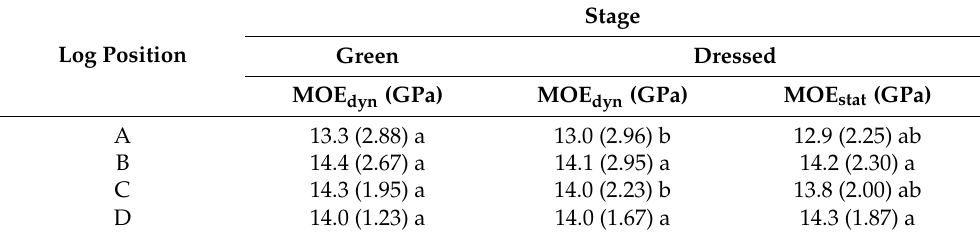
Table 3. Repeated measures ANOVA results table of modulus of elasticity measured at different green and dressed stages (as MOE dyn and MOE stat ) in boards coming from logs of different positions in the stems (bottom A, middle B and C and top logs D). Different letters across rows denote differences in modulus of elasticity at the various processing stages for boards coming from the same log.